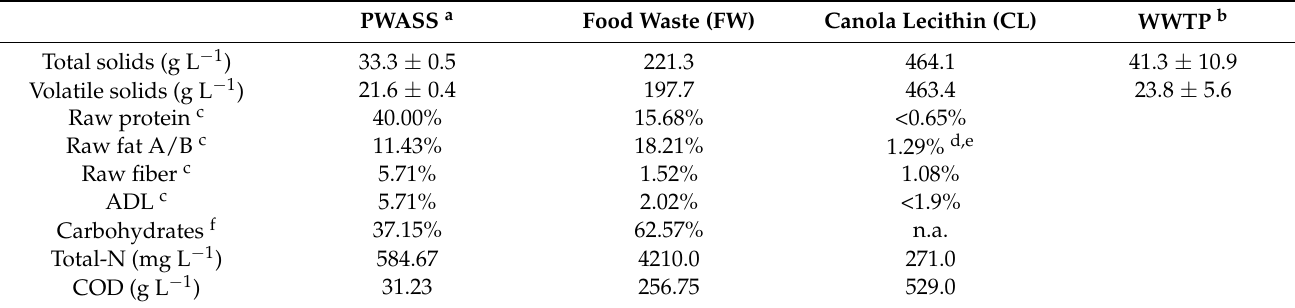
Table 1. Characterization of the different substrates.